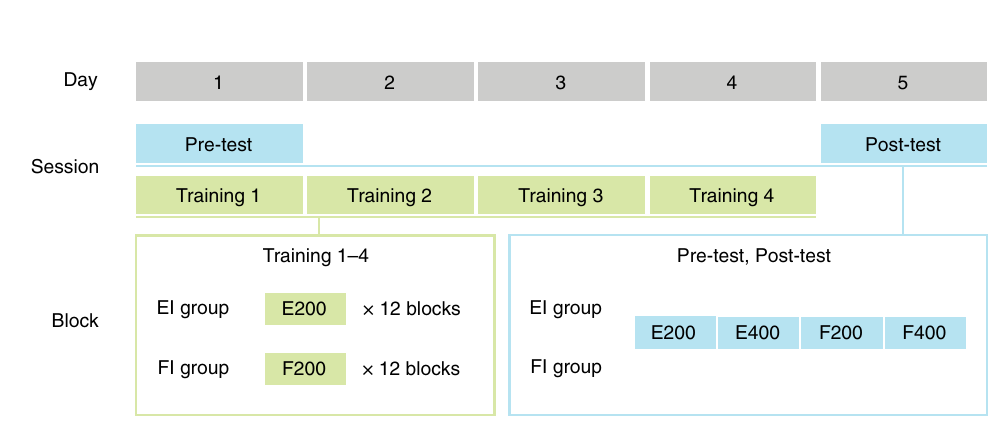
Table 1. Summary of psychophysical research on TPL. It lists the modality of the trained stimuli (A: auditory, T: tactile, V: visual), whether the trained stimulus formats were empty or filled intervals, whether the same trained stimuli produced learning in post-training tests, and whether the learning effect transferred between empty and filled intervals. In reports of successful learning, only one study 15 used filled intervals. The transfer results had two outcomes: empty intervals transferred to filled intervals (E to F) and not tested (–). To our best knowledge, no study has yet examined the transfer from filled intervals to empty intervals or reported the absence of transfer when tested.